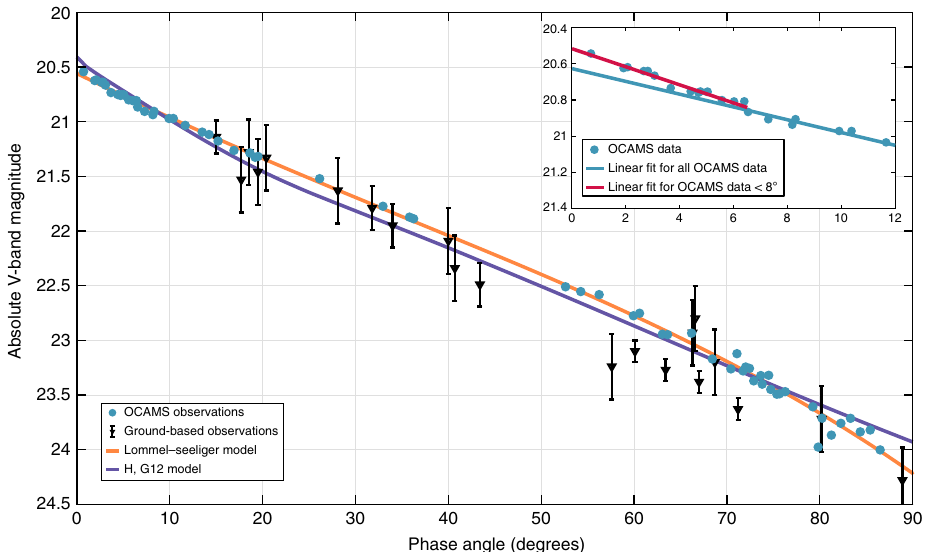
Fig. 3 Phase function observations and models for Bennu. Over-plotted are the model fi ts to the new data: a Lommel-Seeliger model and a revised H , G 12 model. The ground-based measurements are published in 18 . We originally converted the ground-based measurements to the v-band magnitude scale, plotted with 1-sigma photometric error bars. The 1-sigma photometric error bars for OCAMS data are less than or equal to the size of the data points. Inset, upper right: The OSIRIS-REx measurements at low phase angles (0 to 12 degrees). We plot this subset of the data to illustrate the small opposition effect present for asteroid Bennu. The small opposition effect is consistent with what we would expect for low-albedo, carbonaceous bodies. The red line is the linear fi t to observations made at less than 7.5 degrees phase angle. The blue line is the linear fi t to all OSIRIS-REx data points at greater than 7.5 degrees phase angle. Source data are provided in Supplementary Tables 2 and